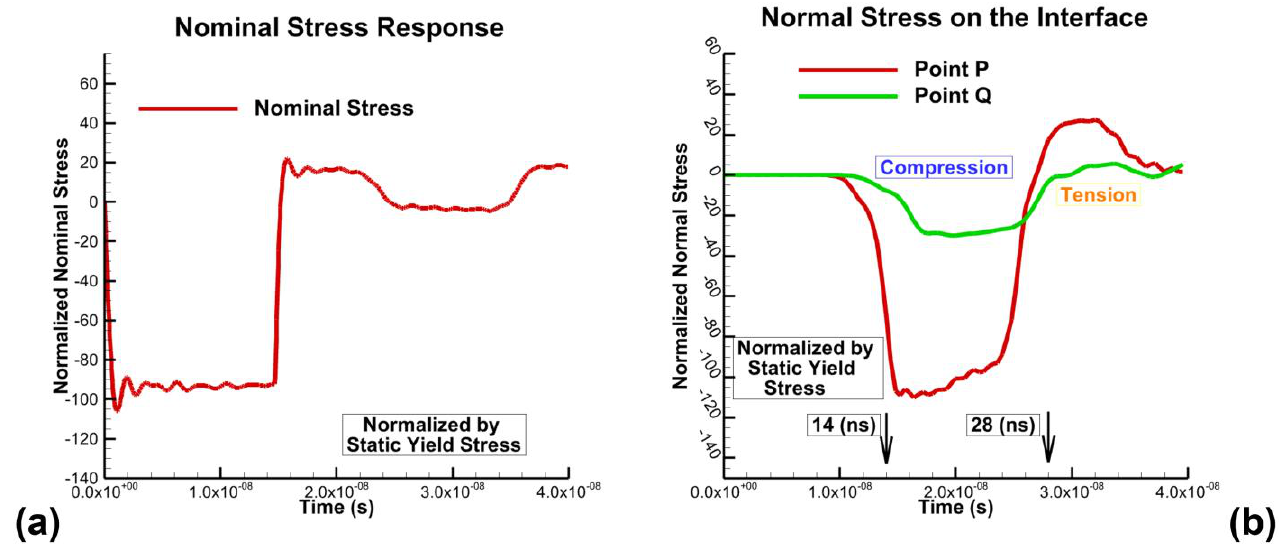
Figure 6. ( a ) Global nominal stress responses, ( b ) normalized normal stress, σ yy ; compressive stresses are at the interface at approximately 14 ns and tensile stress reaches the interface at around 28 ns.